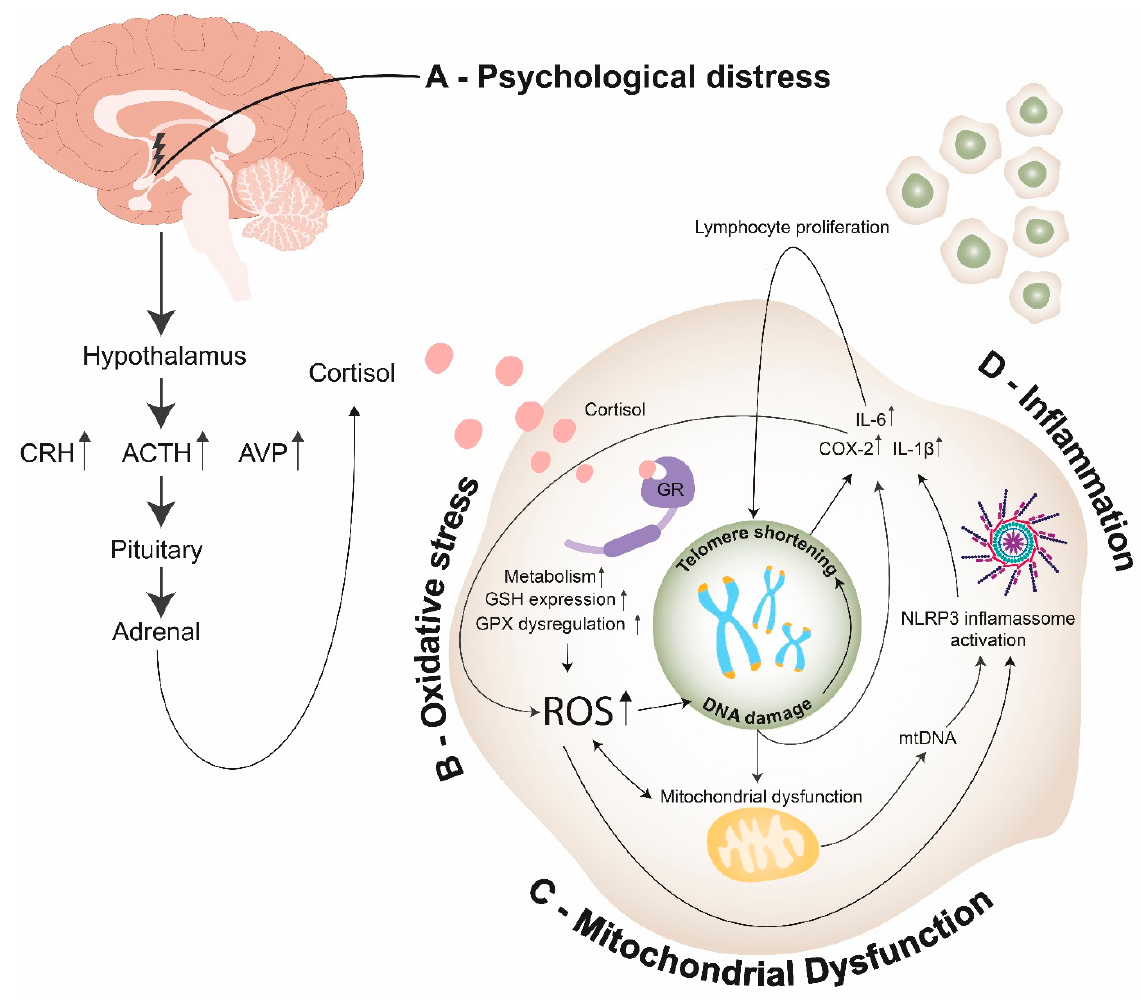
Figure 3. Endocrine, cellular, and molecular mechanisms linking psychological distress to telomere shortening: ( A )—Psychological distress promotes cortisol release through the hypothalamus–pituitary–adrenal axis (HPA axis); ( B )—In the intracellular environment, cortisol promotes the activation of GR, leading to an increase of cell metabolism, GSH expression and GPX dysregulation, thus enhancing the production of ROS. ROS can promote telomere shortening through different pathways: (1) Promoting direct DNA damage; (2) Promoting mitochondrial dysfunction, which induces an increase of ROS; (3) Promoting NLRP3 inflammasome activation. ( C )—Mitochondrial dysfunction promotes ROS production and mtDNA release on cytosol, which results in telomere shortening through activation of NLPR3 inflammasome; ( D )—DNA damage and NLRP3 inflammasome activation promote COX-2 and pro-inflammatory cytokine expression, resulting in the synthesis of ROS and lymphocyte proliferation—thus inducing telomere shortening. (ACTH—adrenocorticotropic hormone; CRH—corticotropin-releasing hormone; AVP—arginine vasopressin; ROS—reactive oxygen species; GR—glu- cocorticoid receptor; GSH—glutathione; GPX—glutathione peroxidase; mtDNA—mitochondrial DNA; NLRP3 inflam-